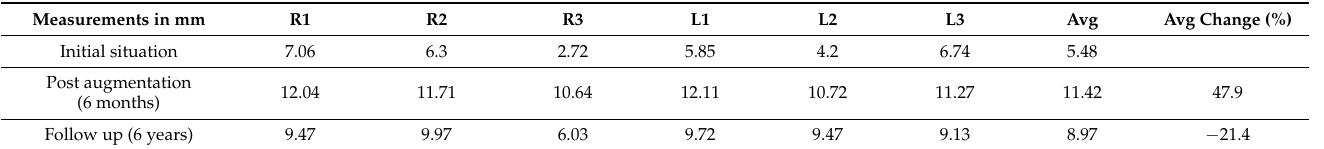
Table 1. Measurements taken in six positions at the same distance from the midline and calculated changes in the alveolar